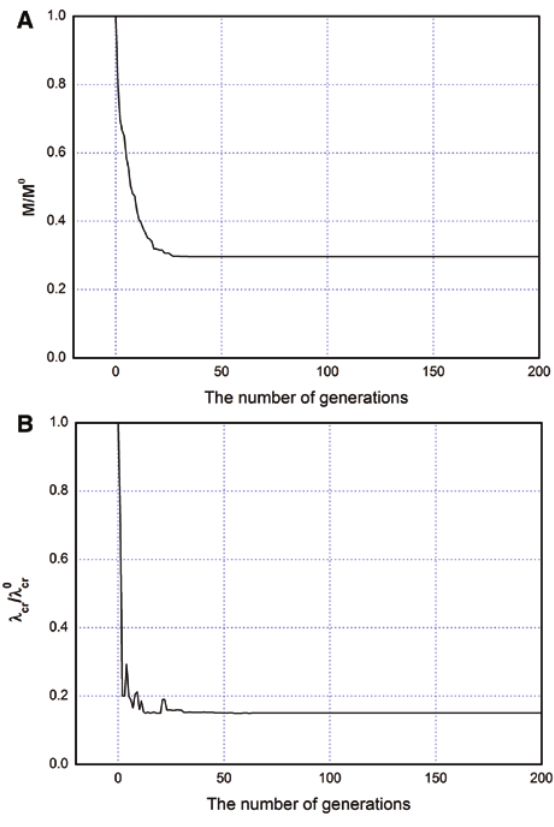
Figure 14: (A) The evolutionary process of the total mass. (B) The evolutionary process of the critical factor. The evolutionary process of design solutions with different core